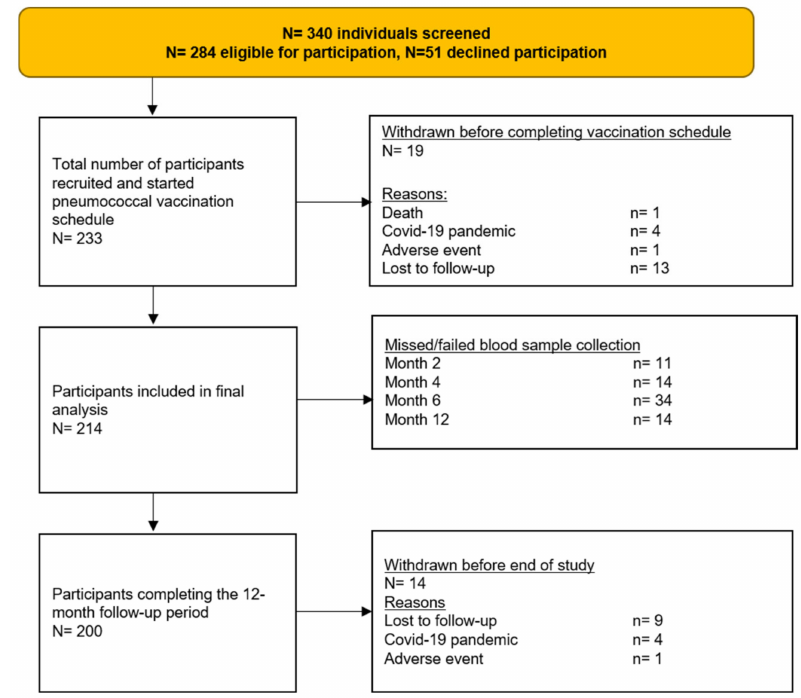
Figure 2. Study flow